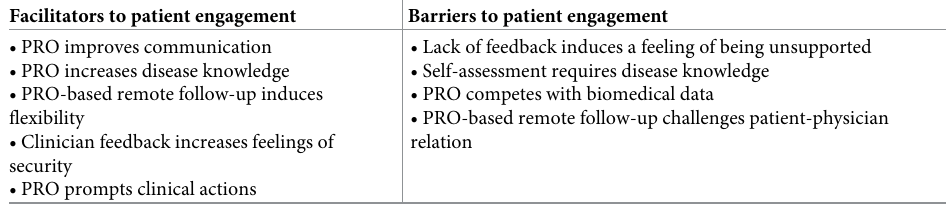
Table 2. Facilitators and barriers towards enhancing patient engagement in PRO-based remote